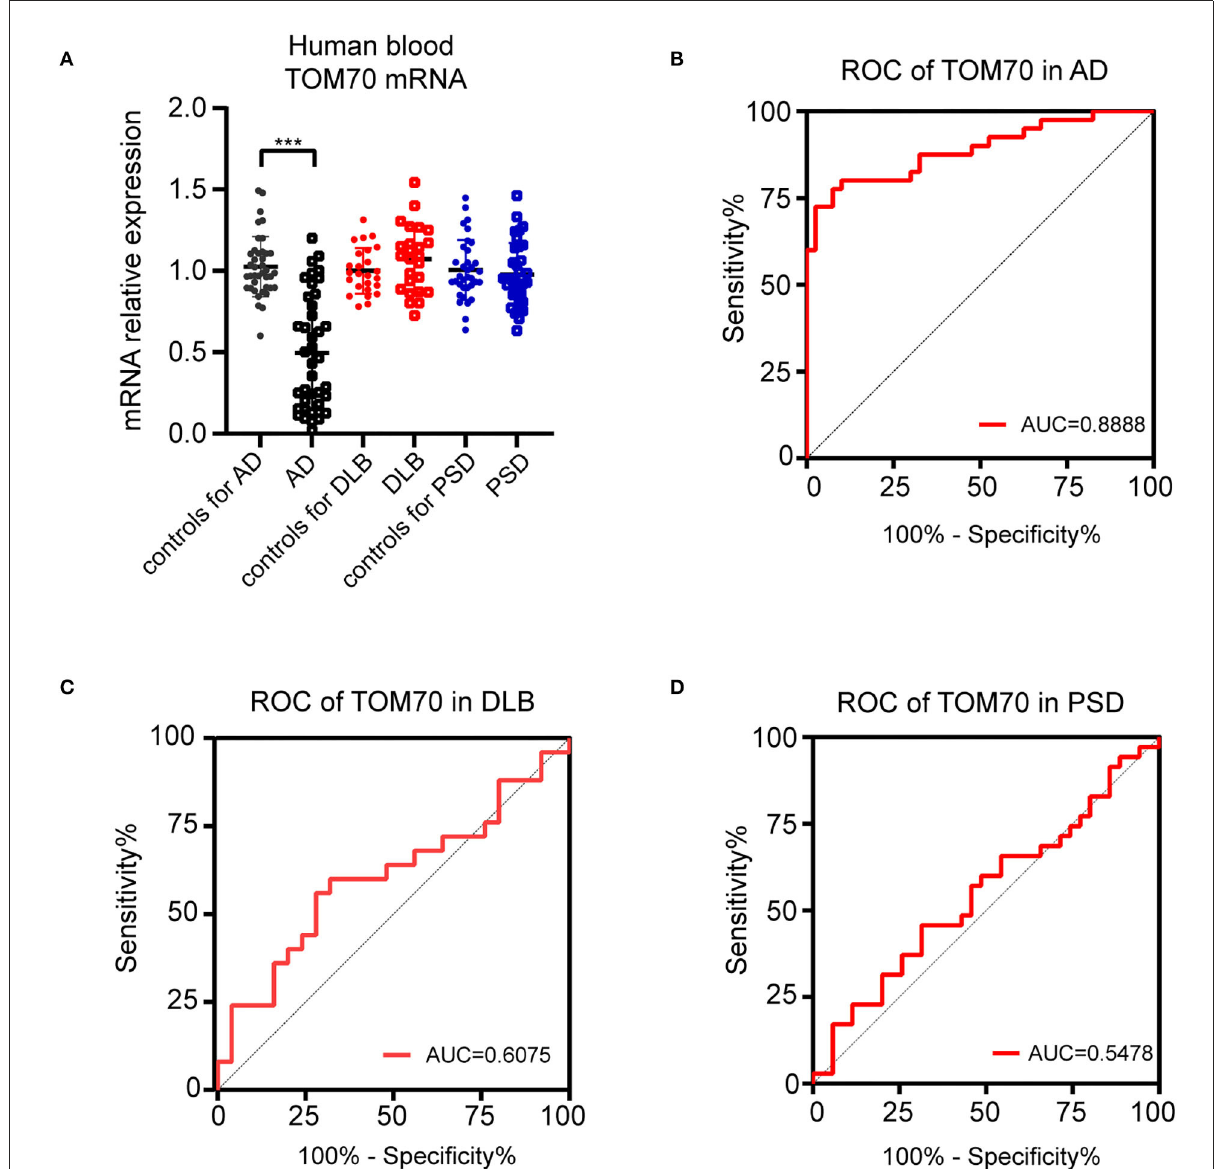
FIGURE1 TOM70 levels in AD, DLB, and PSD. TOM70 mRNA levels from peripheral blood were significantly decreased in AD patients, as compared to normal groups. (A) TOM70 mRNA levels in peripheral blood of AD, DLB, and PSD patients with age- and sex-matched controls. (B) ROC curve of TOM70 in AD. (C) ROC curve of TOM70 in DLB. (D) ROC curve of TOM70 in PSD. Data are expressed as fold change compared with β -actin mRNA levels. Paired Student’s t- test. *** P <